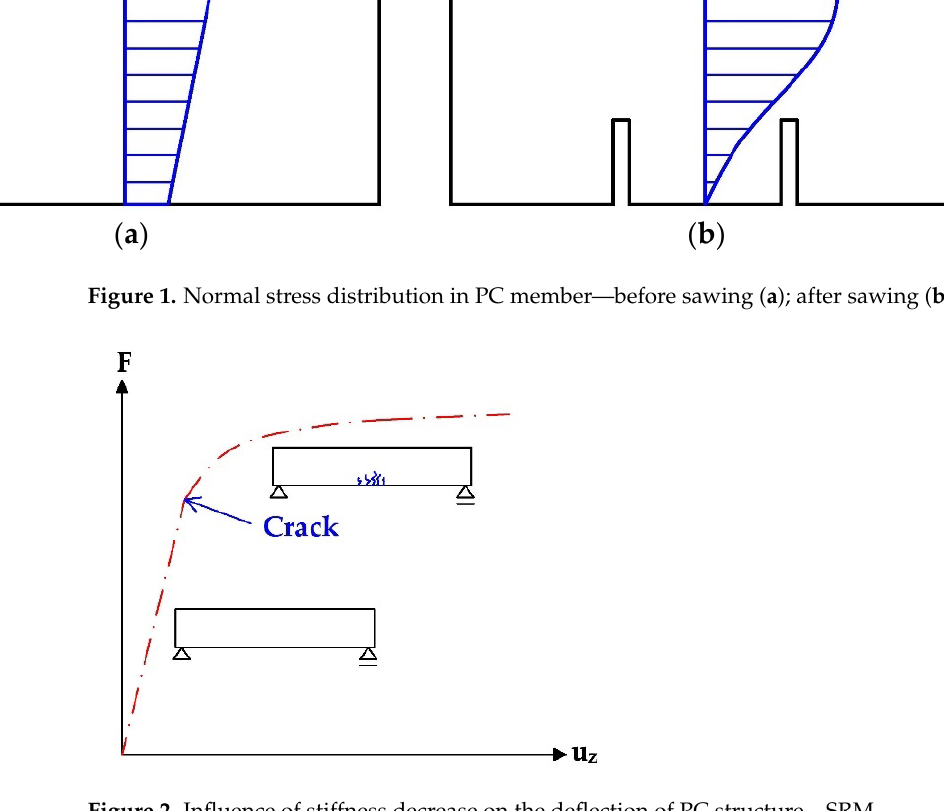
Figure 2. Influence of stiffness decrease on the deflection of PC structure—SRM.